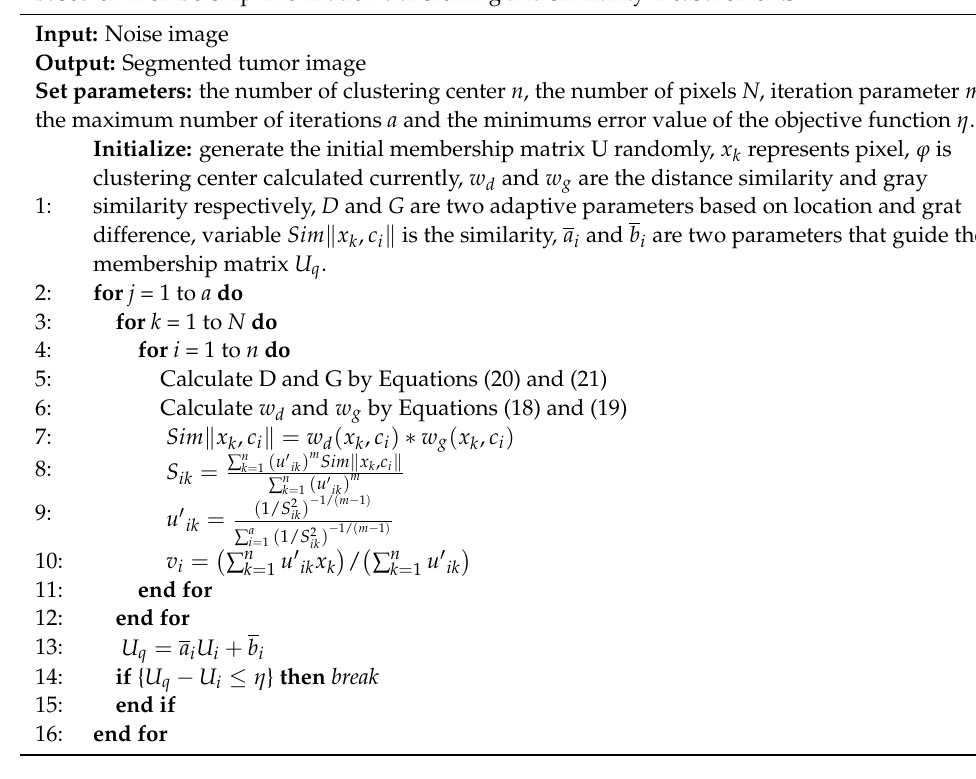
Algorithm 1: Flow of the proposed algorithm. IFCM-MS: intuitionistic fuzzy C-means algorithm based on membership information transferring and similarity